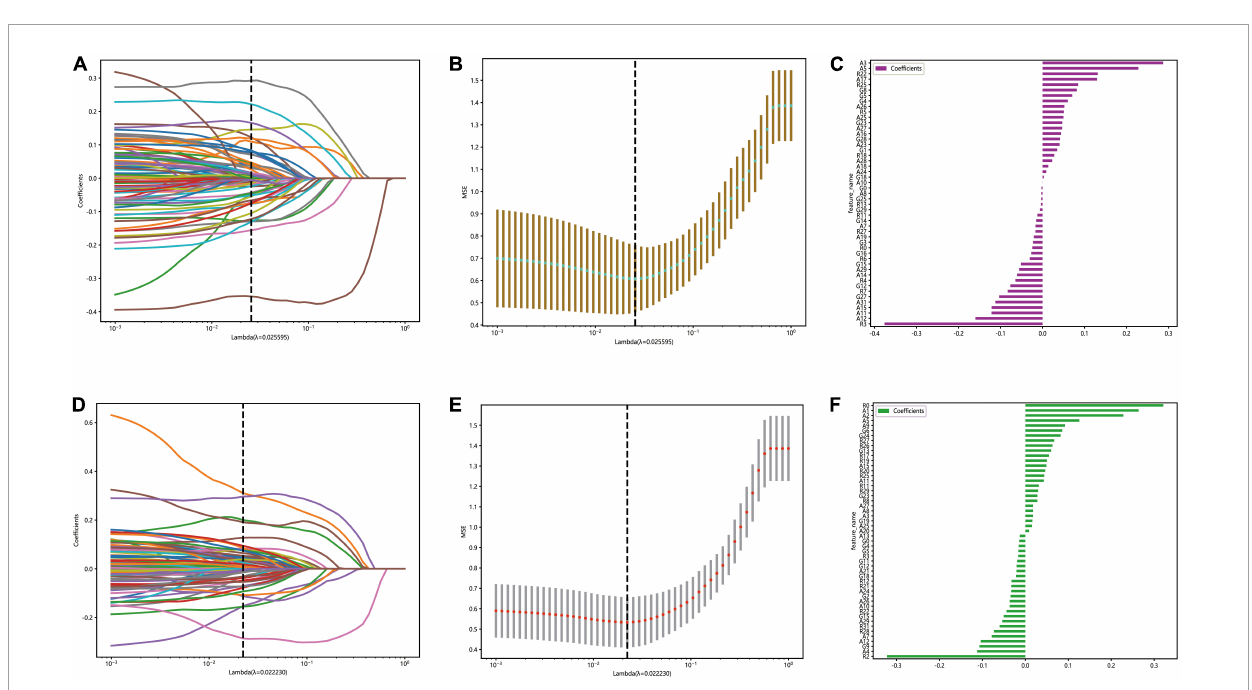
FIGURE4 The figure of LASSO coefficient distribution (left): the colored curve shows the path of the coefficients for each input feature as lambda varies; the figure of partial likelihood deviation of the LASSO coefficient distribution (middle): the vertical dashed line represents the optimal value of the regularization parameter determined by cross-validation; feature weight coefficient graph (right). Automatic segmentation platform (A–C) ; manual segmentaion platform (D–F)